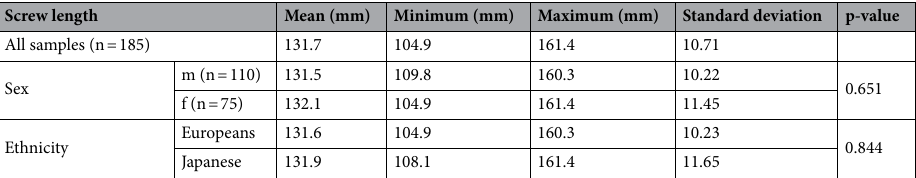
Table 1. Statistical overview of the screw length. Screw length shows a consistent range also comparing subgroups (sex and ethnicity). Statistical analysis was performed using Mann–Whitney-U-Test for independent samples and confirmed the observation that there is no significant difference between the groups.